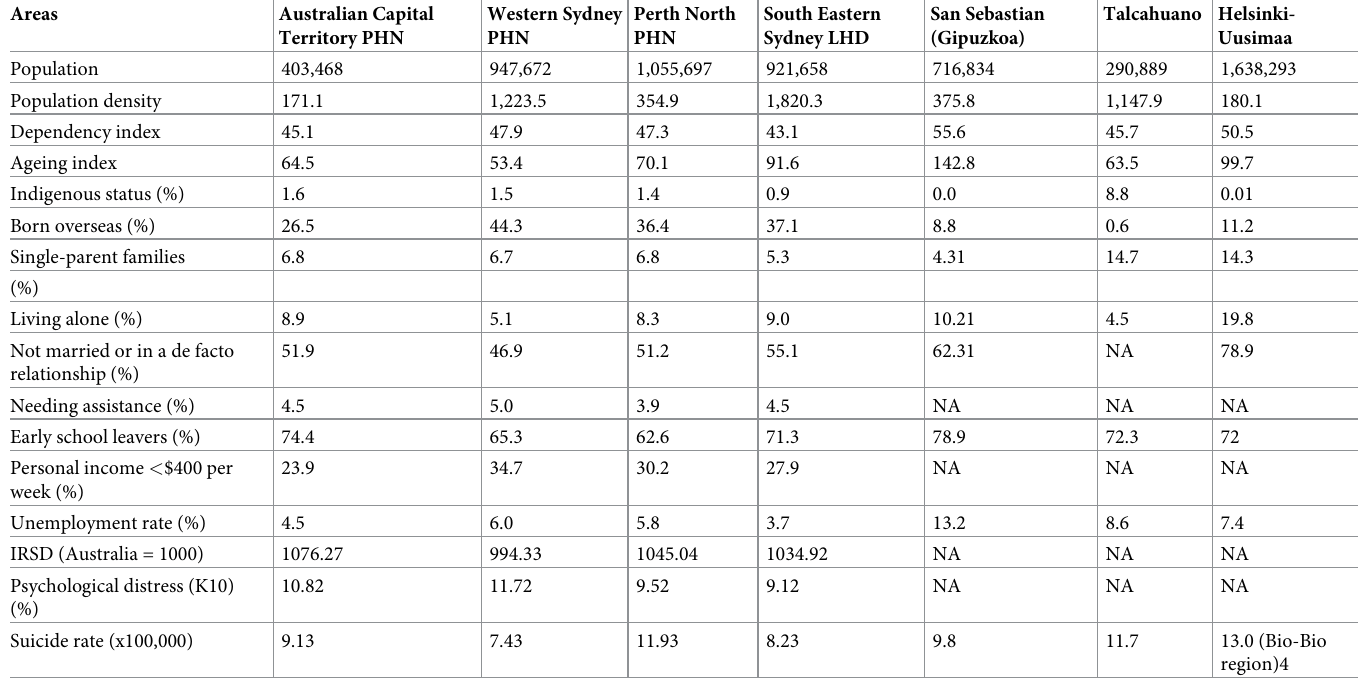
Table 1. Socio-demographic indicators of the study